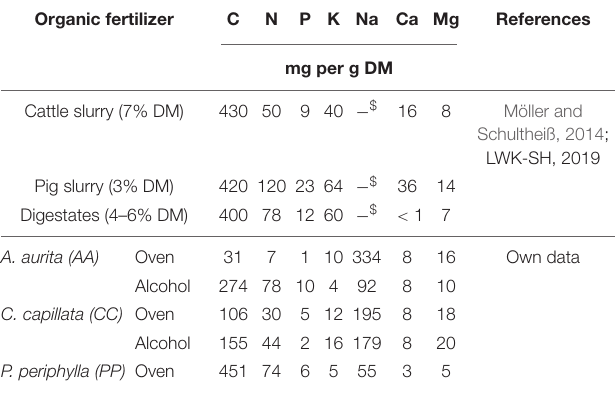
TABLE 4 | Nutrient contents as in dry matter (DM) from reference values reported for selected organic manures from housed livestock in comparison with that of jellyfish in the present